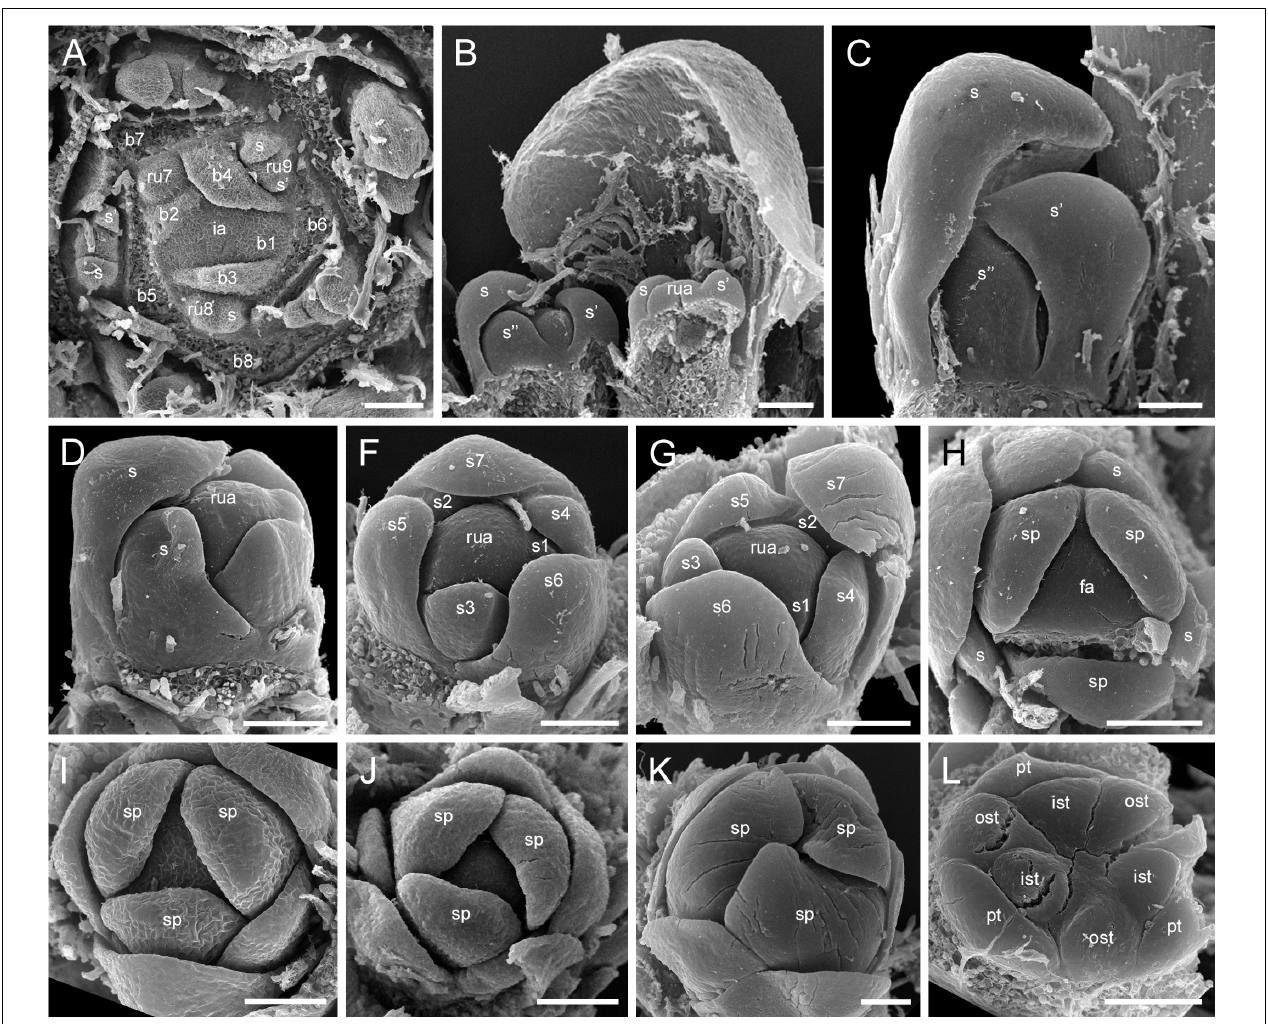
FIGURE 9 | Flower development in Rapateoideae. Duckea junciformis , early flower development. (A) Inflorescence tip with initiating RUs (“spikelets”). RUs appear in axils of RU-subtending bracts. The first visible RU is present in the axil of seventh youngest bract. Bracts are numbered starting from inflorescence apex. Numbers of RUs correspond to their subtending bracts. Phyllomes on the RU axis first appear in RU located in the axil of 8 th bract. (B,C) Young RUs with spirally initiating phyllomes, viewed from adaxial side. Phyllomes are labeled in the order of their initiation (s, first; s’, second; s”, third). (D–G) Later RUs with spirally initiating phyllomes, numbered starting from RU apex. (H) RU terminated by a flower with sepals initiated. Note that sepals alternate with the uppermost phyllomes, which are smaller than the sepals. Sepal estivation is valvate at this stage. (I,K) Subsequent stages of calyx enlargement. Sepals grow and their estivation becomes contort. (L) Initiation of petals and androecium. Sepals removed. B, RU-subtending bract; fa, floral apex; ia, inflorescence apex, ist, inner stamen; ost, outer stamens; pt, petals; rua, RU apex; s, phyllomes on RU axis; sp., sepals. Scale bars = 100